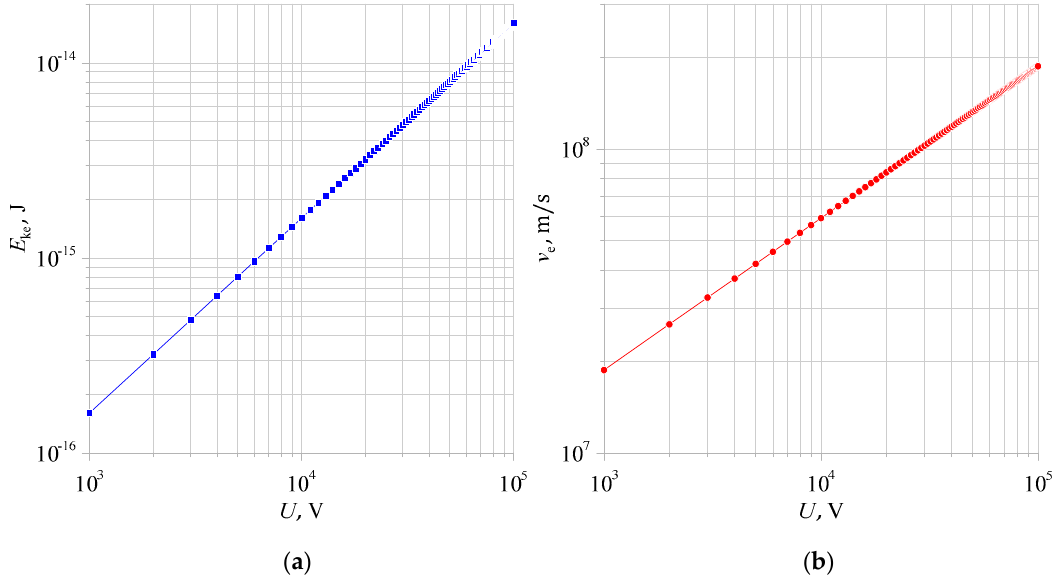
Figure 3. The dependence of: ( a ) electron kinetic energy E ke and ( b ) electron velocity υ e as a function of voltage U applied to the electrodes.